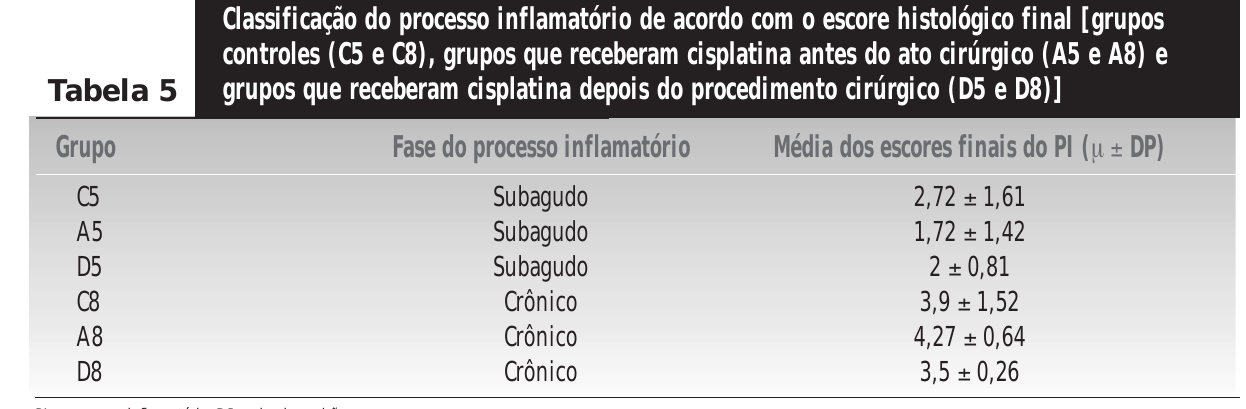
cados como subagudos. O grupo controle (C) apresentou média de 3,28 e foi classificado como